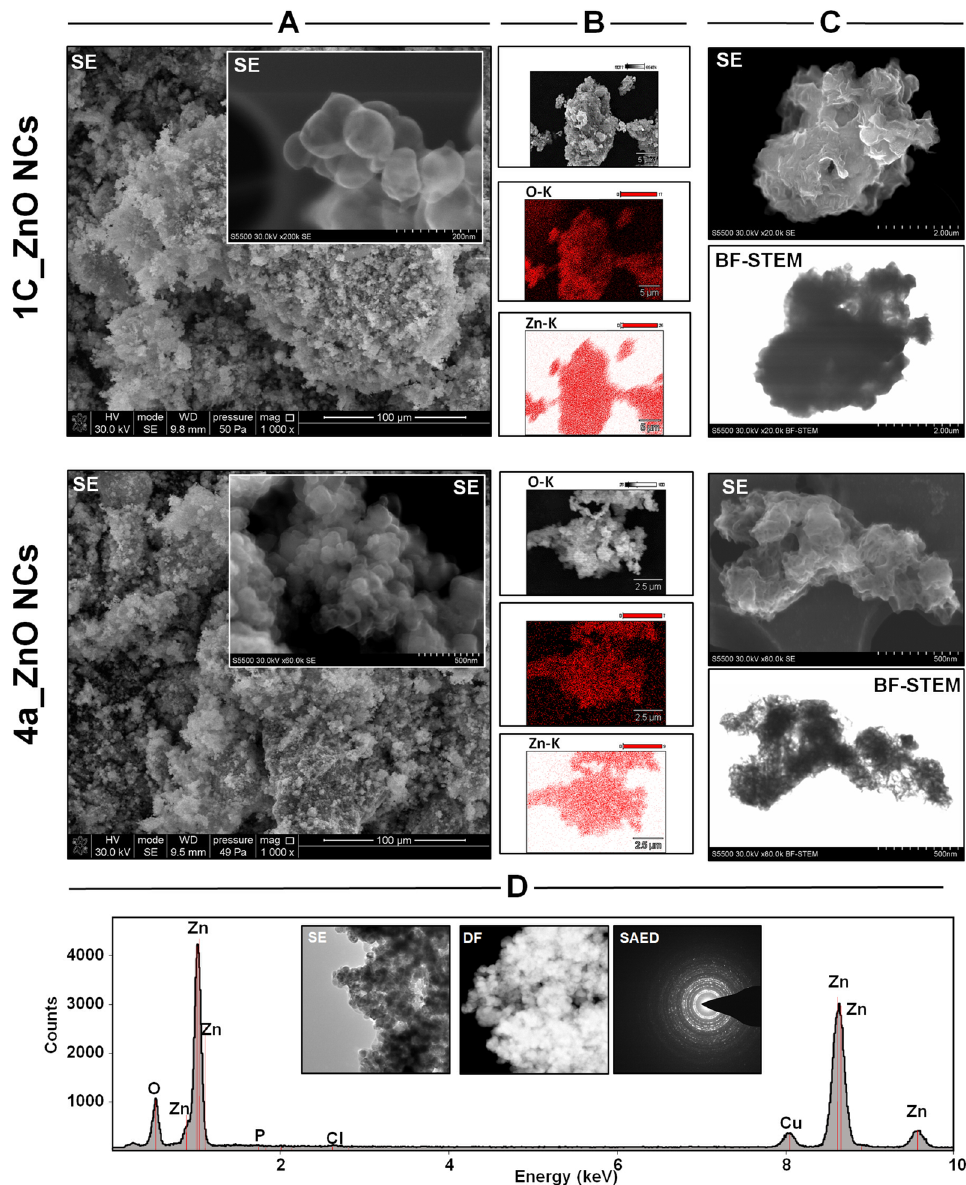
Figure 2. The electron micrographs for the 1C and 4a_ZnO NCs; SEM images in SE mode ( A ), SEM mapping ( B ), STEM images in SE and BF modes ( C ) and TEM images in BF, DF, SAED modes with EDX detector ( D